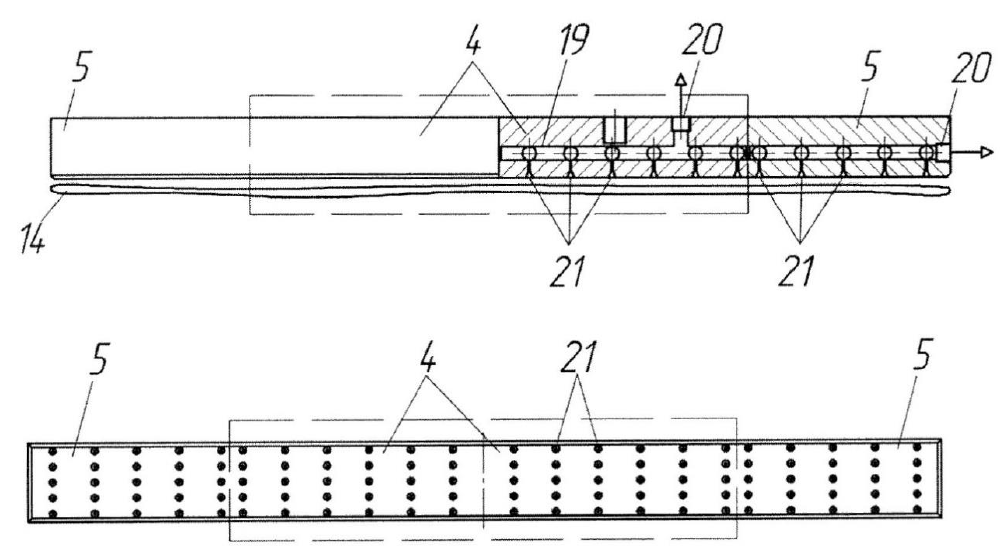
Figure 17. Scheme of the vacuum gripping device.